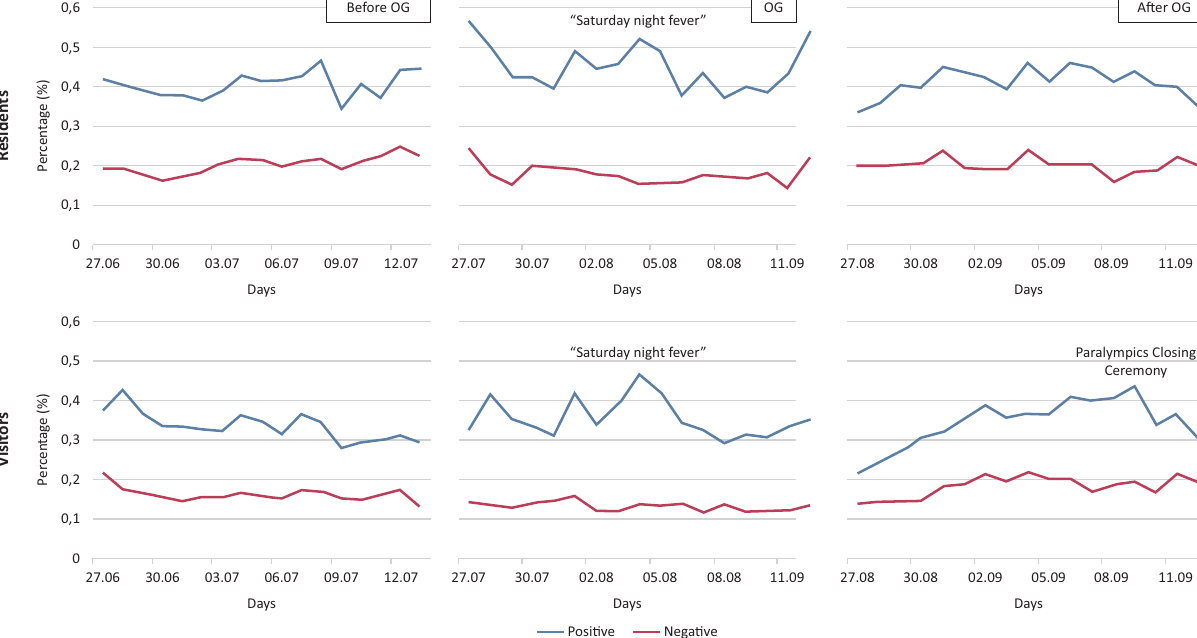
Figure 6. Daily sentiment analysis distribution for residents and visitors for “all tweets” (percentage of total number of tweets in the given temporal bin for the respective